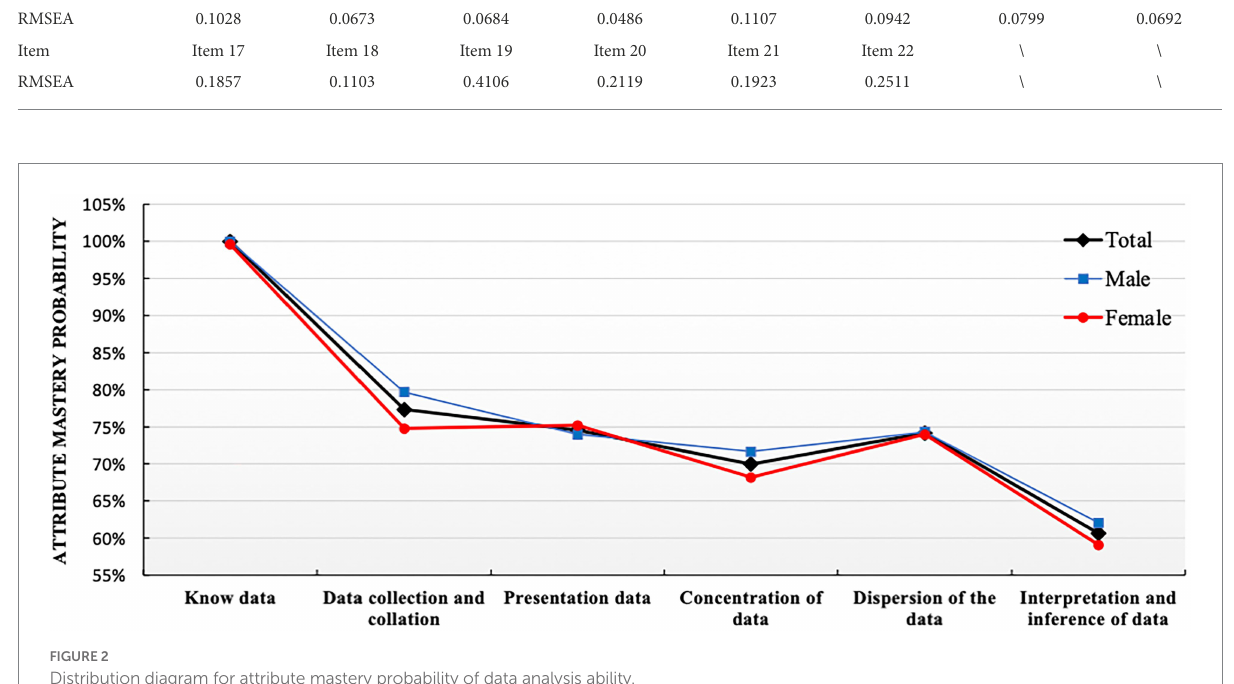
FIGURE 2 Distribution diagram for attribute mastery probability of data analysis